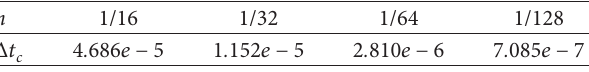
h c with respect to